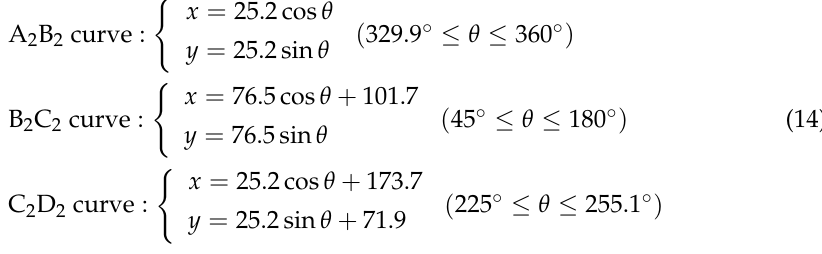
Figure 15. The 3D model of shrimp. 2.3.2. Simulation Model The 3D model of the segmented clamping mechanism was established by SOLID- WORKS software. In the clamping mechanism and the shrimp action model, the shrimp is in contact with the clamping plate in a posture with the abdomen facing down and the tail consistent with the movement direction. The model was then imported into the AD- AMS software, as shown in Figure 16. To simplify the motion analysis, only two sets of clamping units were set in the 3D model of the clamping mechanism.